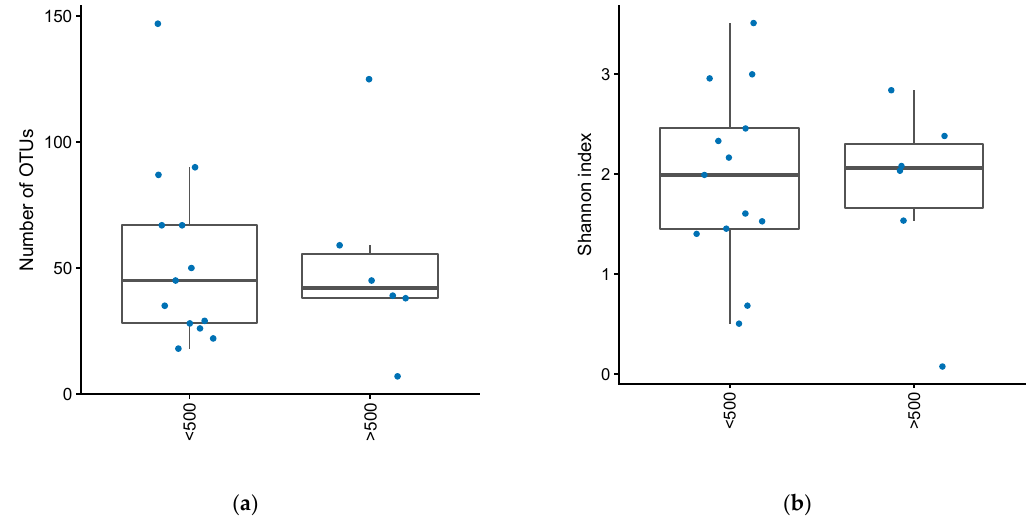
Figure 2. ( a ) Number of OTUs in patients with an ileo-anal pouch anastomosis, with or without increased inflammation in their pouch. Increased inflammation defined as fecal calprotectin greater than 500. ( b ) Shannon diversity index in patients with an ileo-anal pouch anastomosis, with or without increased inflammation in their pouch. Increased inflammation was defined as a fecal calprotectin greater than 500.